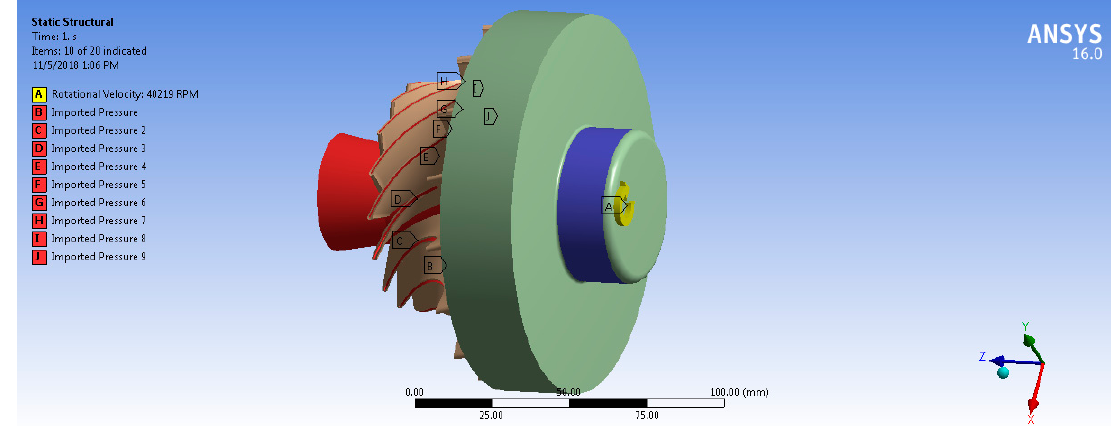
Figure 13. Rotational velocity (A), cylindrical support (blue surface) for the turbine model and imported pressure on the rotor blades (B, C, D, E, F, G, H, I, J)